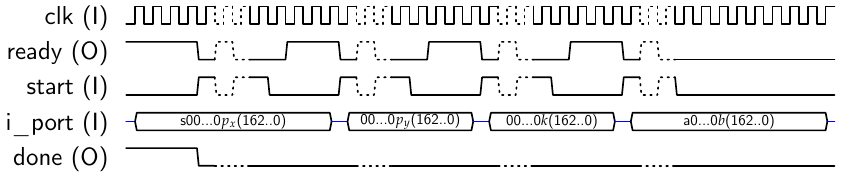
Figure 13. Sequence for loading p x , p y , k , a and b .